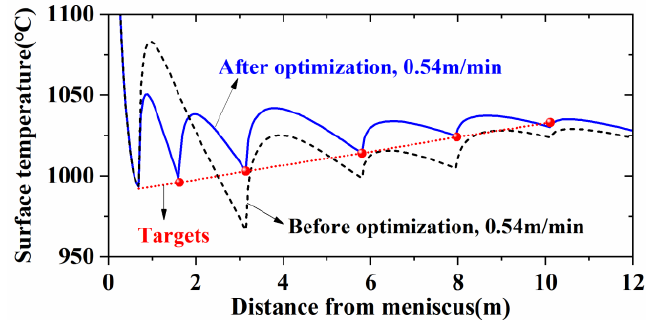
Figure 11. Temperatures before and after optimization.